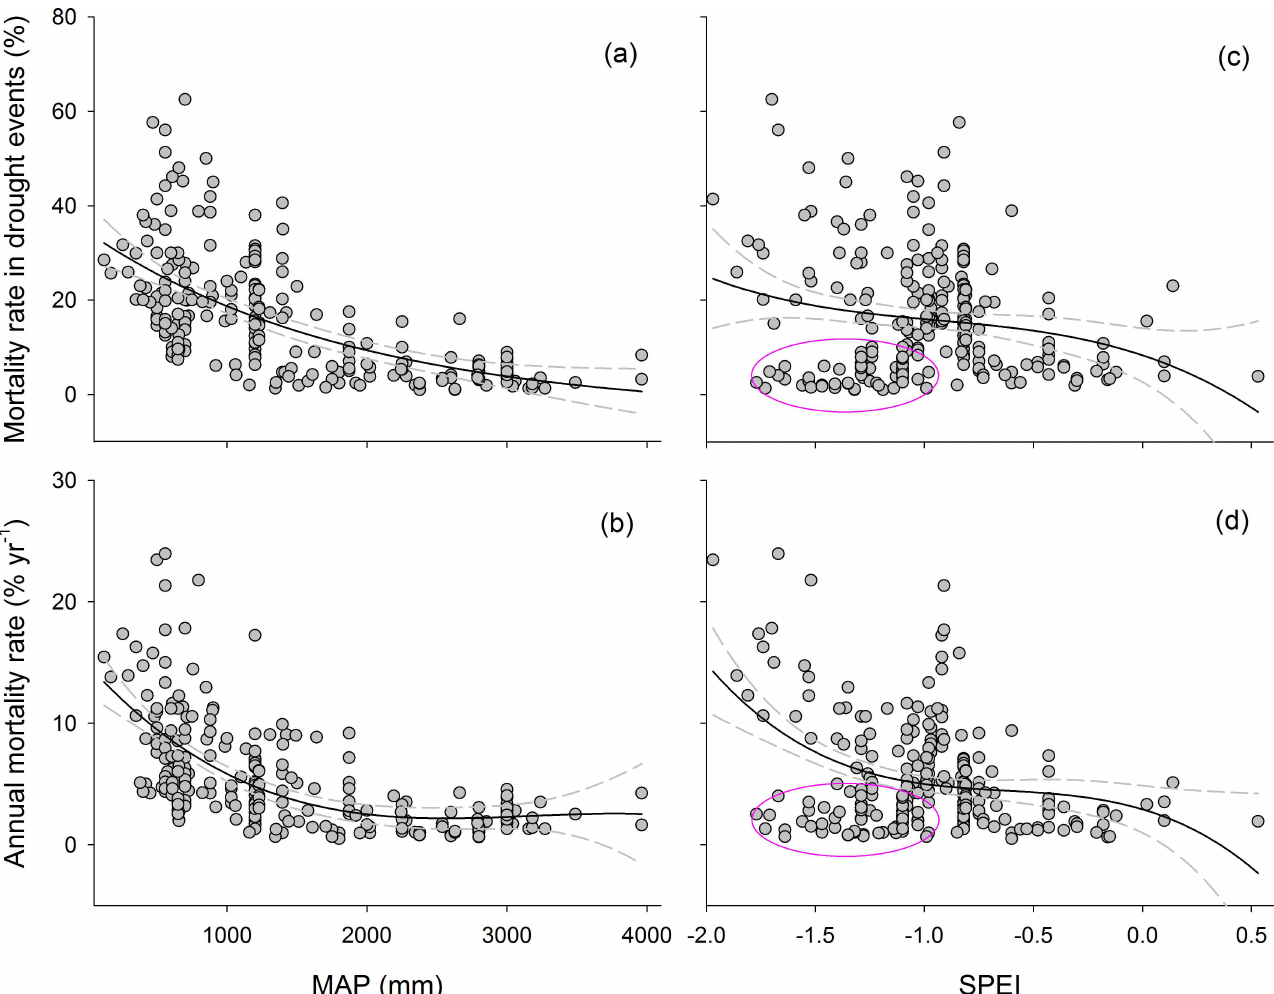
Fig 3. Sensitivity of mortality to drought for all sites with available data. (a) and (b) showedrelationshipsbetween tree mortality metrics and MAP. (c) and (d) showedrelationshipsbetween tree mortality metrics and SPEI. Dark-grey dots indicatedroughts. The best-fit models for each drought index and mortality-rate metric are shown, with the 95% bootstrapped confidenceintervals. MAP, mean annualprecipitation;SPEI, standardizedprecipitation-evapotranspiration index. The pink ovals indicate the lower tree mortality rate for tropical rainforests.